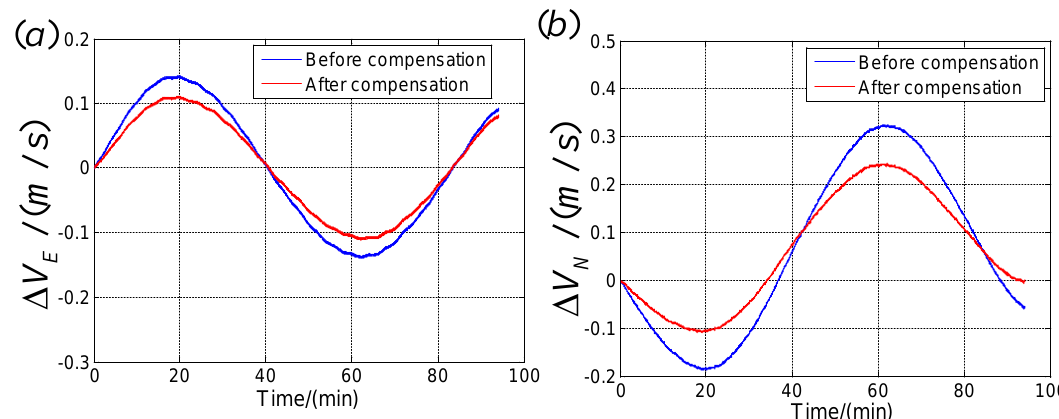
Figure 7. Navigation results before and after compensating the calibration results. ( a )Velocity errors in east direction compensation; ( b ) Velocity errors in north